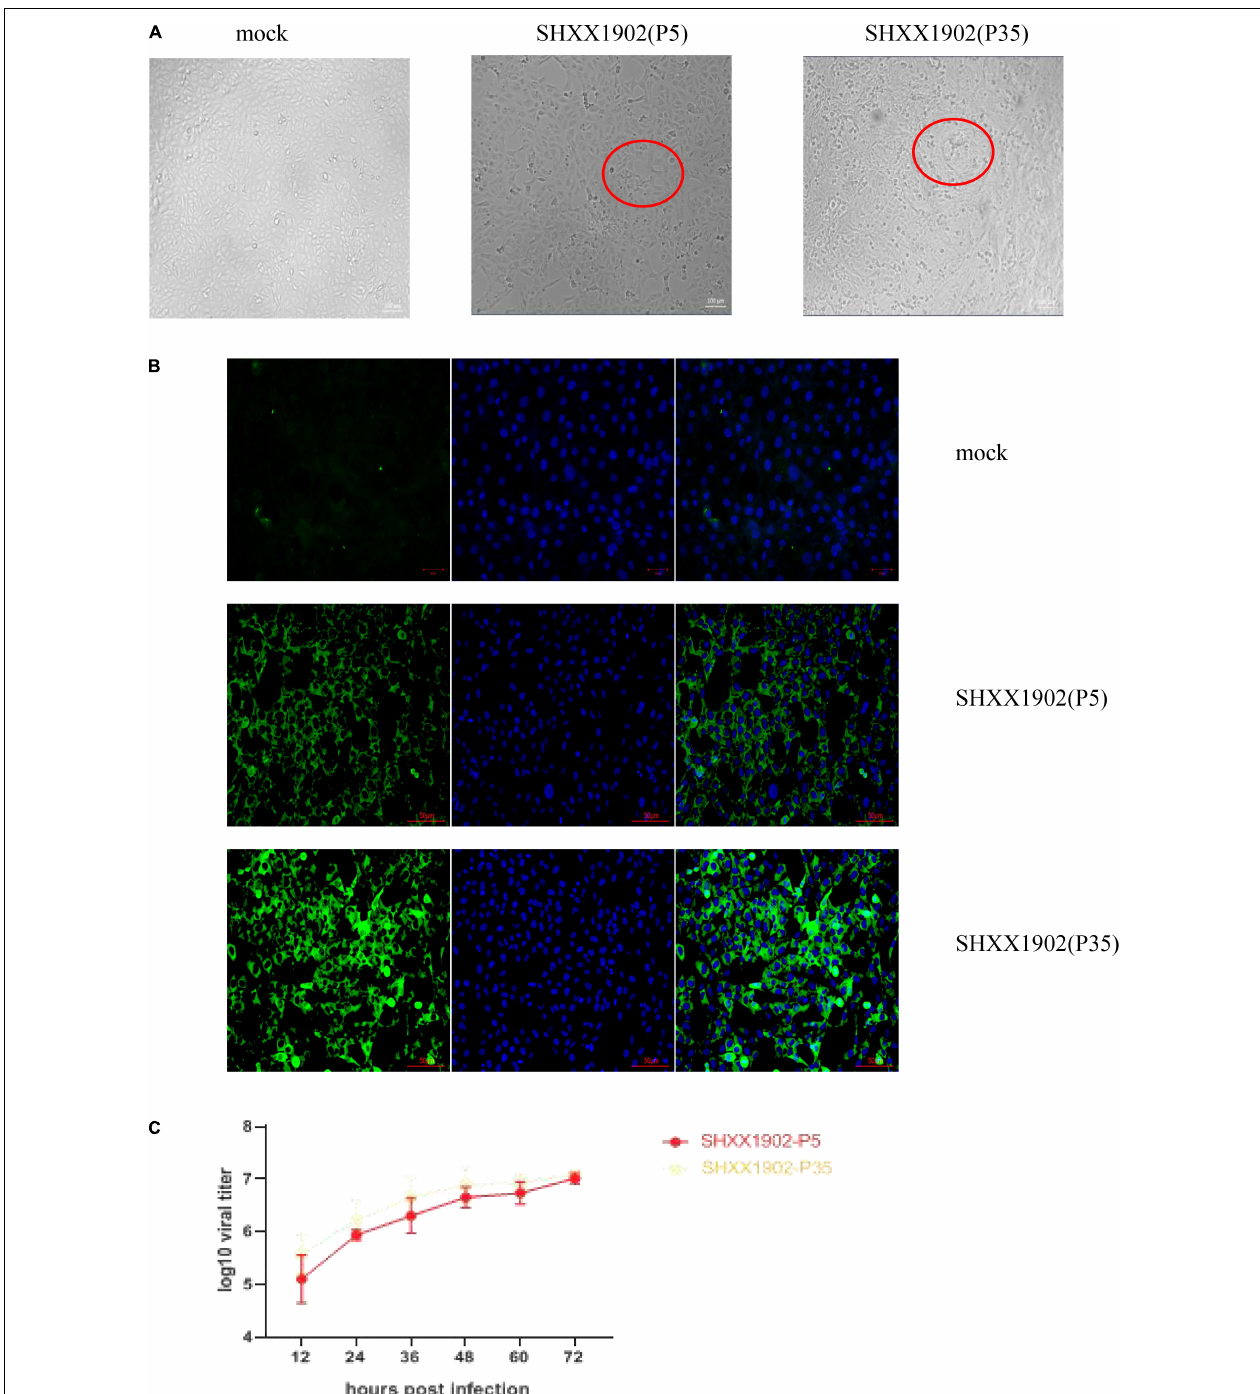
FIGURE 1 | Cytopathology and growth properties of PEDV SHXX1902. (A) CPE formation in Vero cells infected with strain SHXX1902-P5 or SHXX1902-P35. PEDV-specific CPE was observed daily, and the cells were photographed at 24 hpi using an inverted microscope at a magnification of × 200. The red circle indicates the CPE. (B) For immunostaining, infected cells were fixed at 24 hpi and incubated with a monoclonal antibody directed against the S protein and then with Alexa-green-conjugated goat anti-mouse secondary antibody. The cells were then examined under a fluorescence microscope at × 200 magnification. (C) One-step growth kinetics of SHXX1902-P5 and SHXX1902-P35. At the indicated time points post-infection, the culture supernatants were harvested from SHXX1902-P5-infected Vero cells, and the viral titers were determined. There was no significant difference between the titers of the two passages ( P > 0.05). CPE, cytopathic effect; PEDV, porcine epidemic diarrhea virus; DAPI, 4,6-diamidino-2-phenylindole; TCID50, median tissue culture infectious dose.